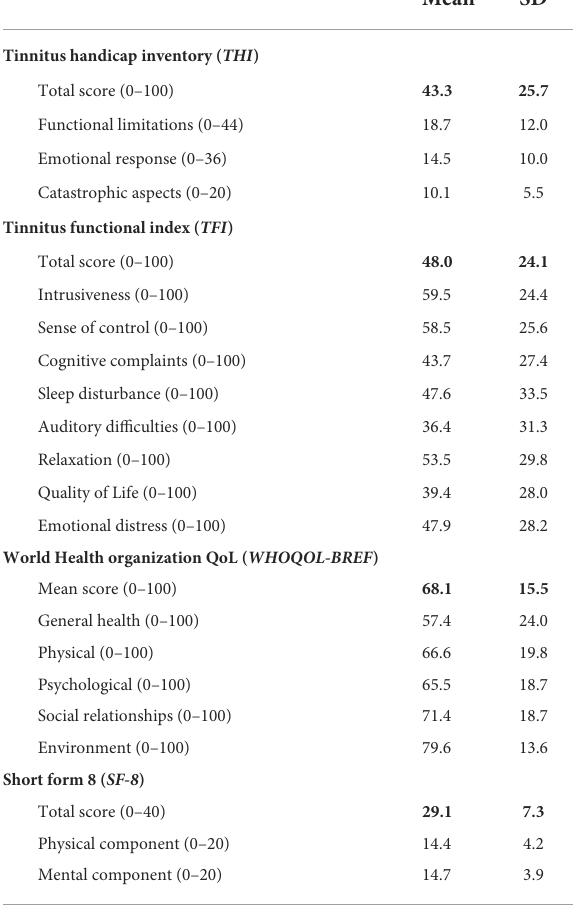
TABLE 2 Distribution of mean and SD scores of all questionnaires and their